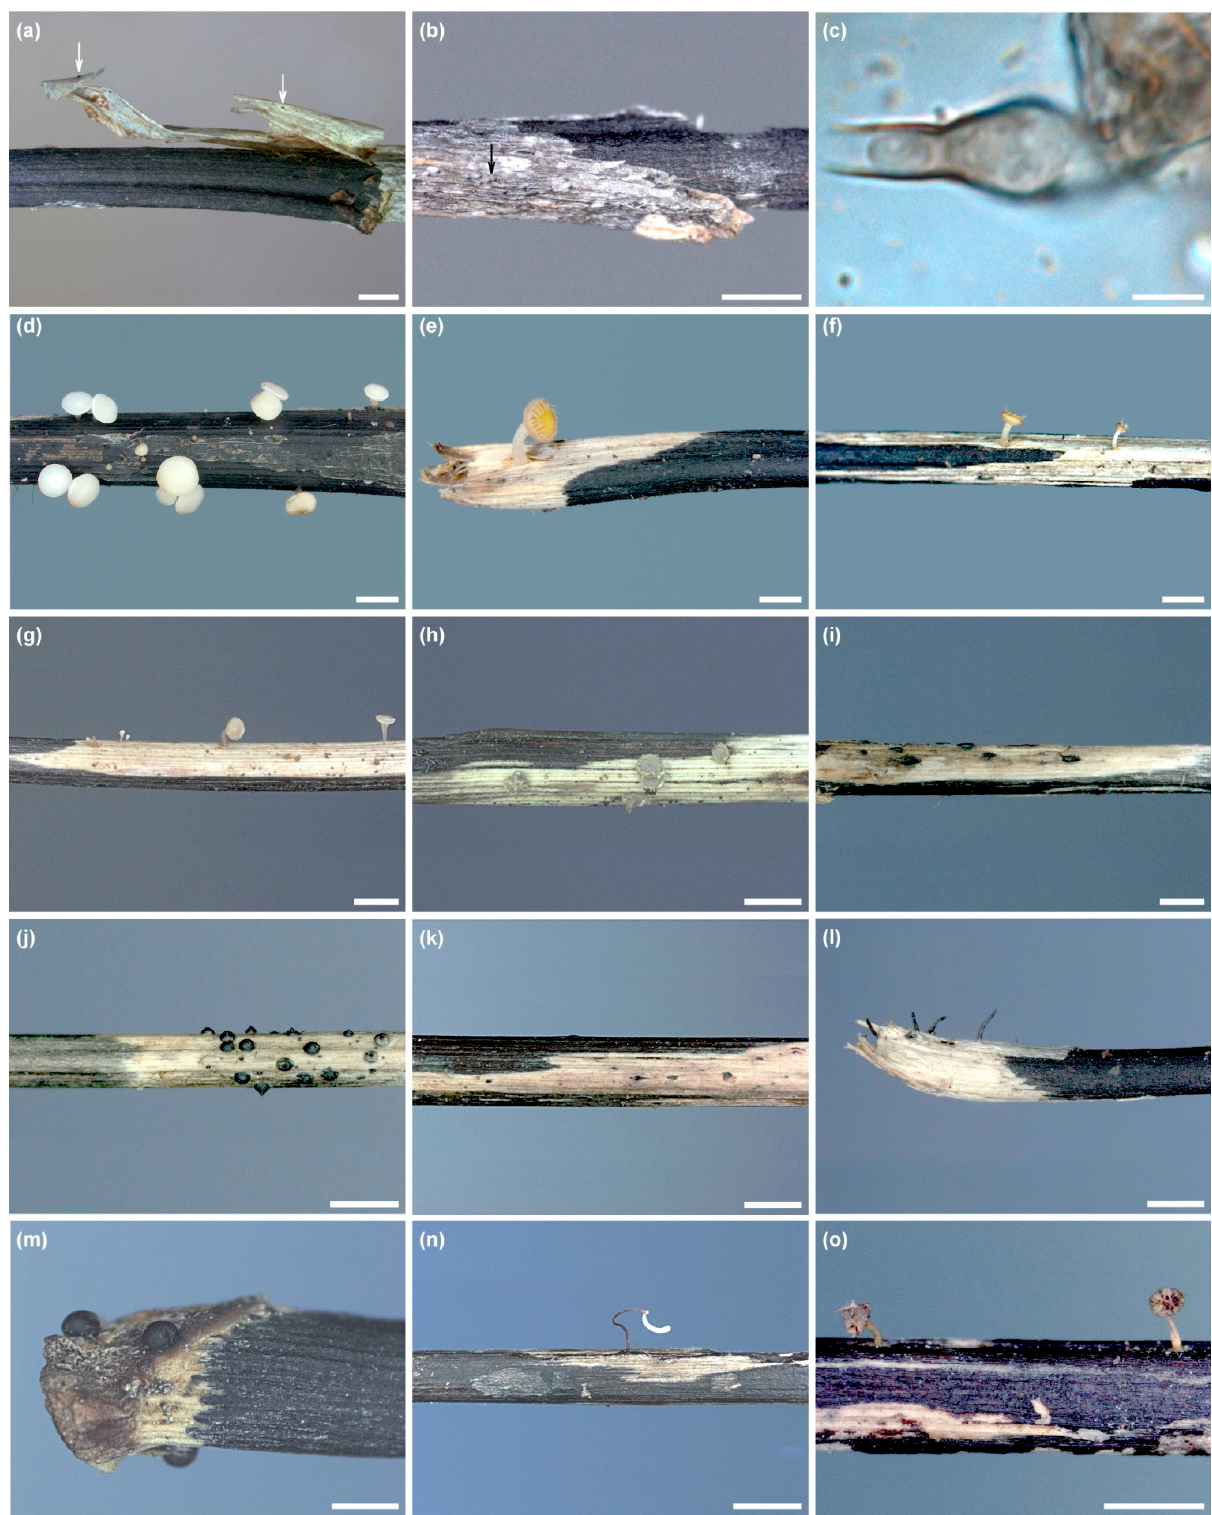
Figure 8. Hymenoscyphus fraxineus and other fungi on the previous year’s leaf petioles of F. excelsior in the litter: ( a , b ) H. fraxineus pseudosclerotial plate revealed by the exfoliating epidermis, with pseudothecia of Venturia fraxini (arrows), ( c ) phialide and endoconidium of Chalara fraxinea on pseudosclerotial plate, ( d ) apothecia of H. fraxineus (July 2017), ( e – n ) pseudosclerotial plate of H. fraxineus and: ( e , f ) Cyathicula coronata , ( g ) Cyathicula fraxinophila , ( h ) Trichopeziza sp. 1, ( i ) Pyrenopeziza petiolaris , ( j ) Leptosphaeria sp. 2, ( k ) Lophiostoma corticola , ( l ) Xylaria sp. 2, ( m , n ) Typhula sp. 2, sclerotium at the base of petiole ( m ), carpogenic sclerotium ( n ), ( o ) apothecia of C. coronata on pseudosclerotial plate of H. fraxineus